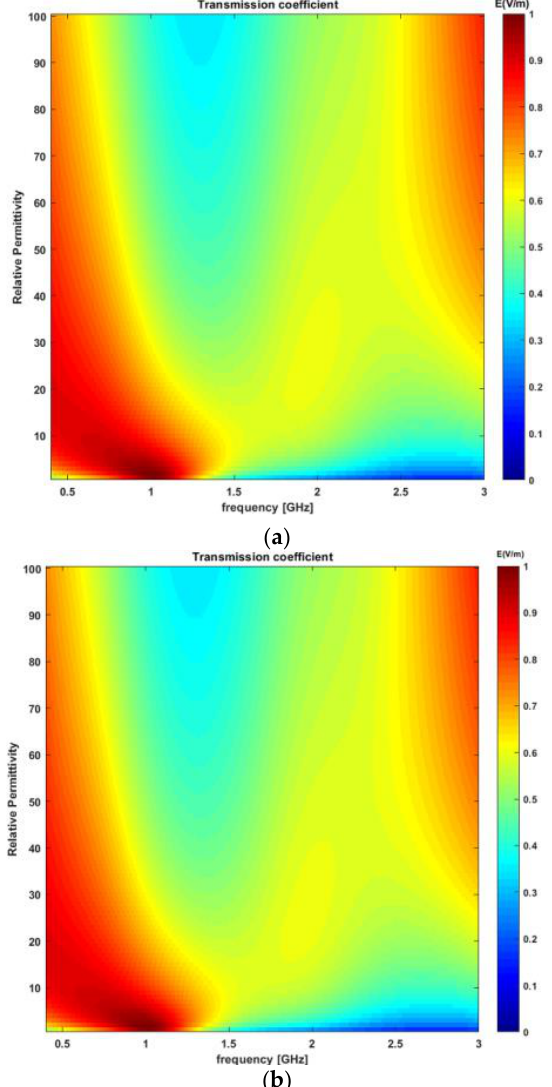
Figure 9. The transmission coefficient as a function of frequency and relative permittivity of matching medium for ( a ) lossless matching medium; ( b ) lossy matching medium with conductivity 0.07 S/m.